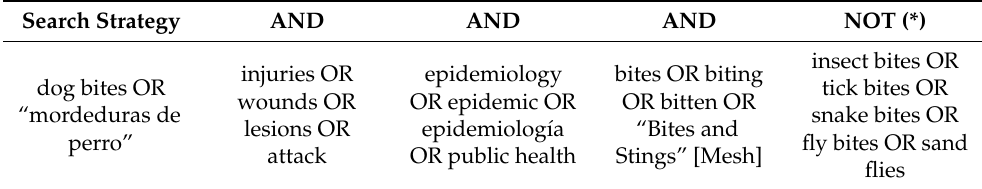
Table 2. Search strategies used in systematic review. The truncation (*) was used to extend the search to all words with a common beginning (e.g., canin